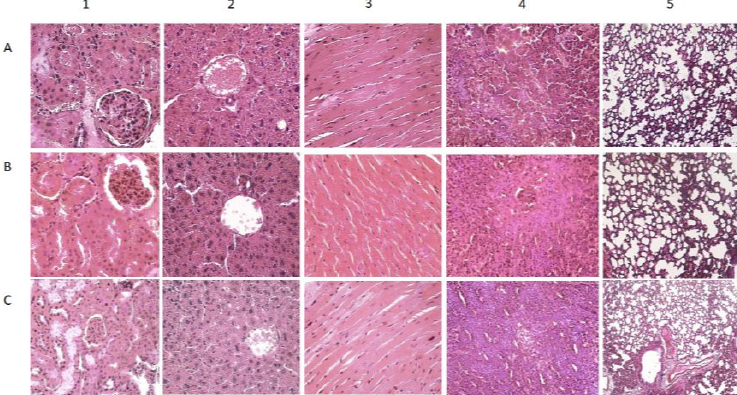
Figure 7. Histological results of the main organs—kidney (1), liver (2), heart (3), spleen (4), and lung (5)—from control ( A ), male ( B ) and female ( C ) mice receiving nanoemulsion. Magnification 100 ×